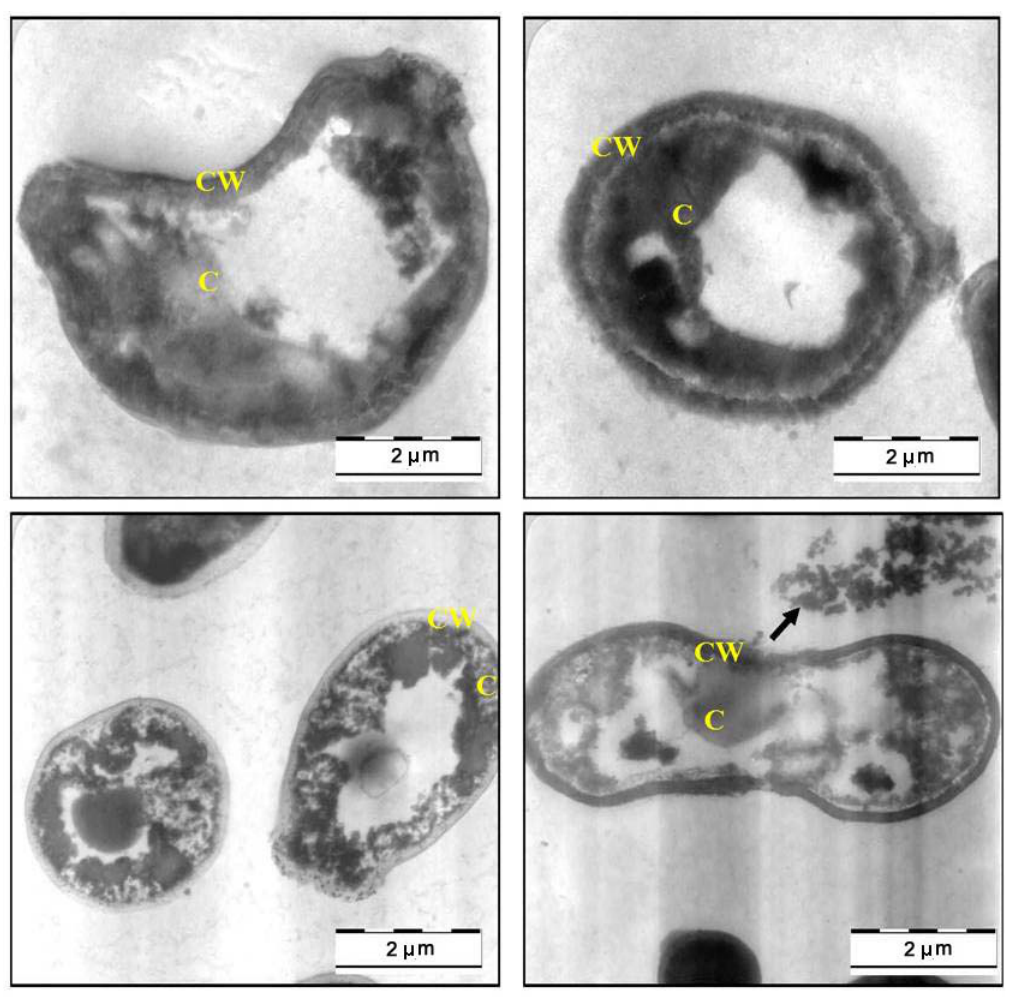
Figure 6. TEM micrograph of a cross-section of the extract treated cell of Candida albicans after 36 h (C: Cytoplasm; CW: Cell Wall).